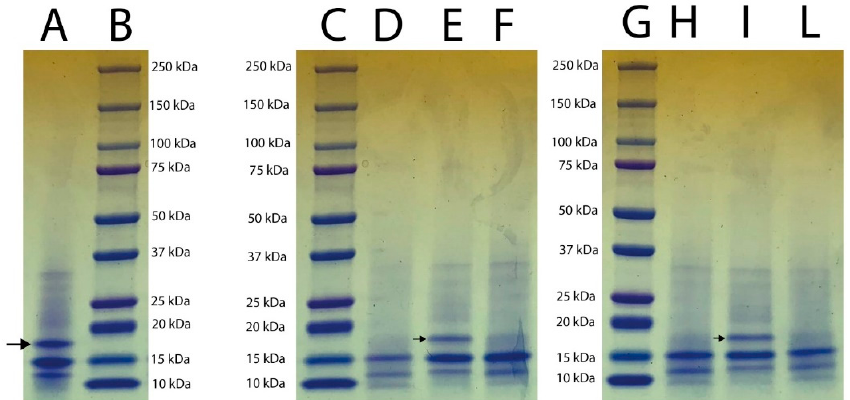
Figure 2. SDS-PAGE patterns of κ -casein subjected to treatment with aqueous extracts of kiwifruit tissues. Lane A: control κ -casein; lanes B, C, G: molecular markers; lane D: ripe fruit pulp; lane E: ripe fruit peel; lane F: ripe whole fruit; lane H: unripe fruit pulp; Lane I: unripe fruit peel; lane L: whole unripe fruit. The arrows indicate the band corresponding to κ -casein (19 kDa, Sigma).